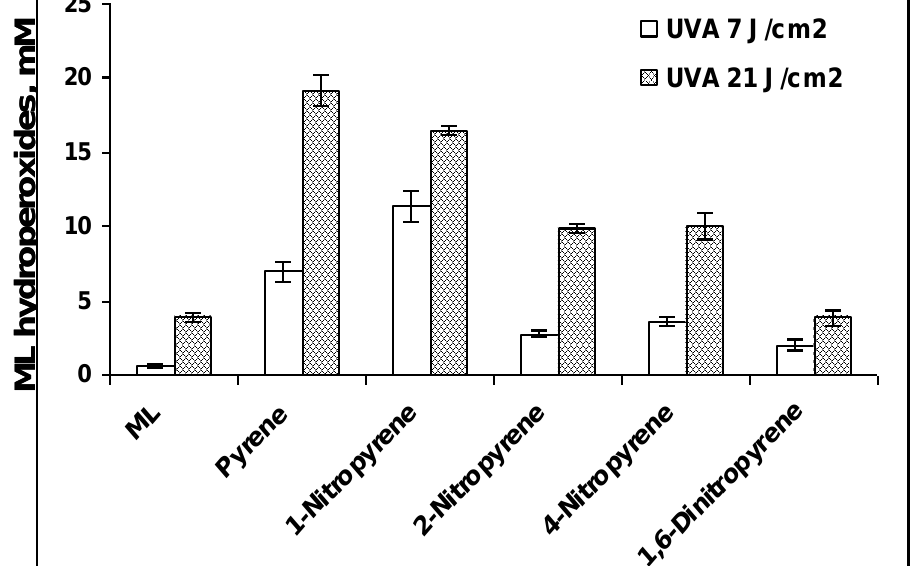
Figure 2. Lipid peroxidation induced by photoirradiation of pyrene, 1-nitropyrene, 2-nitropyrene, 4-nitropyrene, and 1,6-dinitropyrene in methanol in the presence of methyl linoleate (ML) with UVA light at a light dose of 7 and 21 J/cm 2 respectively. The levels of peroxidation were measured by HPLC analysis monitoring the elution at 235 nm.